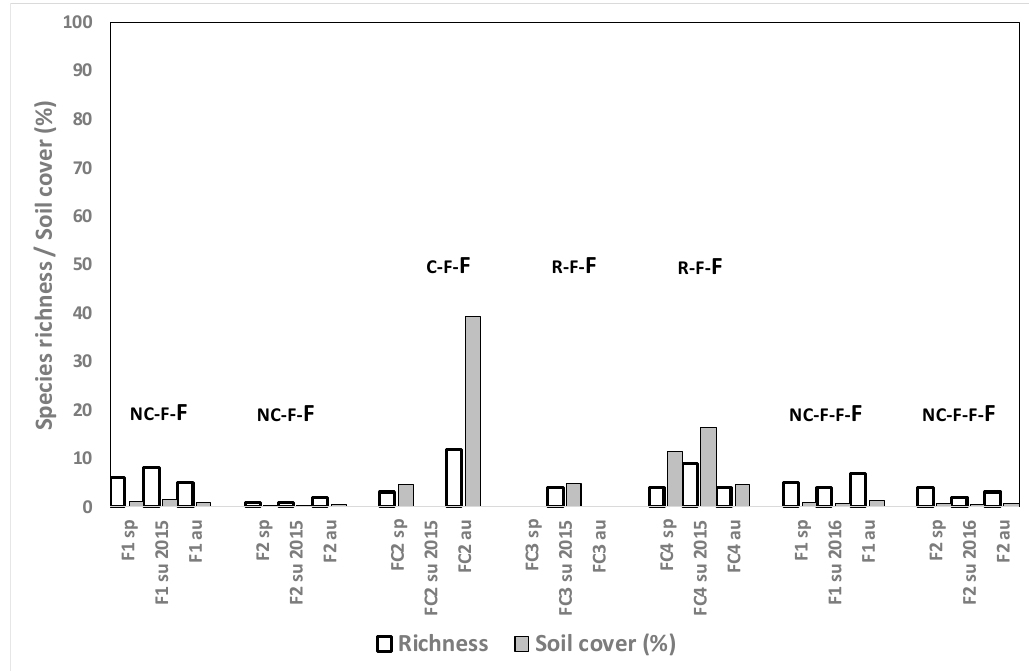
Figure 6. Weed species richness and total weed soil cover (%) for the fescue fields in their second or third year of estab- lishment (F1 and F2 in 2016) in spring (sp), summer (su) and autumn (au) in different crop rotation sequences. Individual species with ≥ 4% soil cover are listed below. The letters show the crops from 2013 until the sampling moment, the sampled crop being the last of the rotation (in larger letters). R: rice, Nc : no crop, F : fescue.